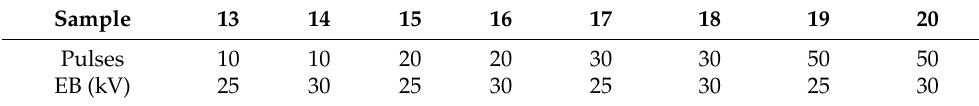
Table 3. Alloying parameters for samples of set